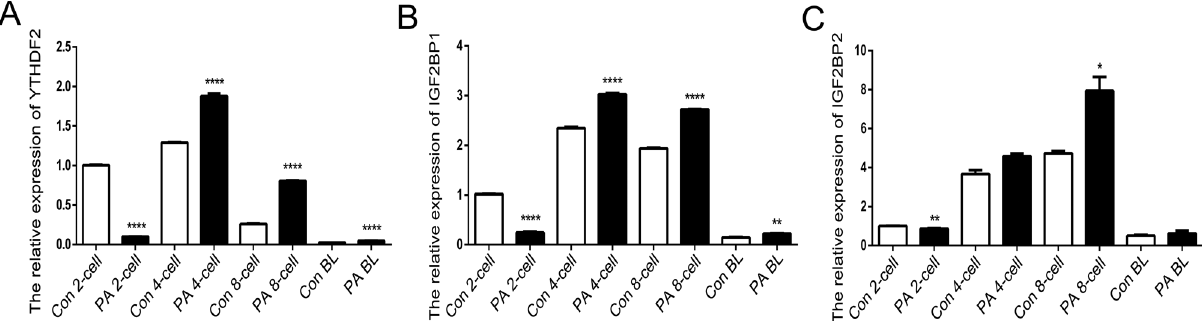
Figure 2 - Relative expression levels of RNA methylation-related genes in normal and PA embryos. The expression levels of YTHDF2 (A), IGF2BP1 (B), and IGF2BP1 (C) were analyzed by qRT-PCR. The data are represented as the mean (cid:3) S.E.M. (n = 3). * p <0.05), ** p <0.01, **** p <0.001 indicate the respective statistically significant differences.